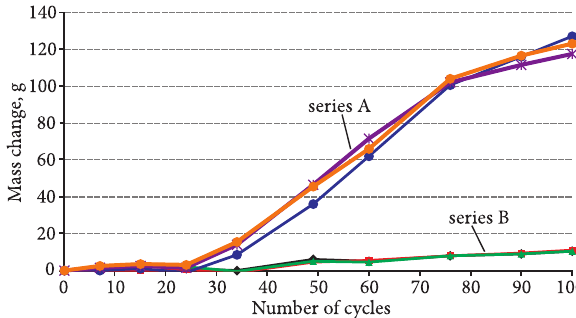
Fig. 5. Mass change of beams frozen in water Table 9. Scaling resistance of concrete in 3% NaCl Property